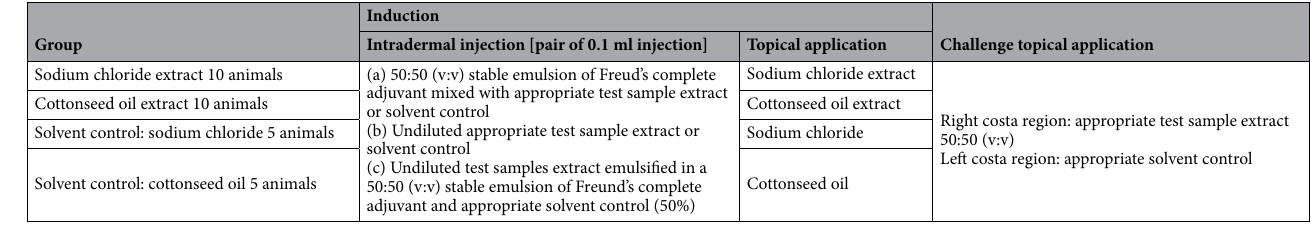
Table 1. Method of application of test